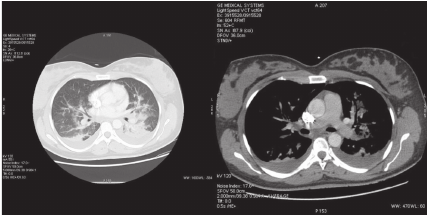
Figure 3: Thoracic angioscan (Case